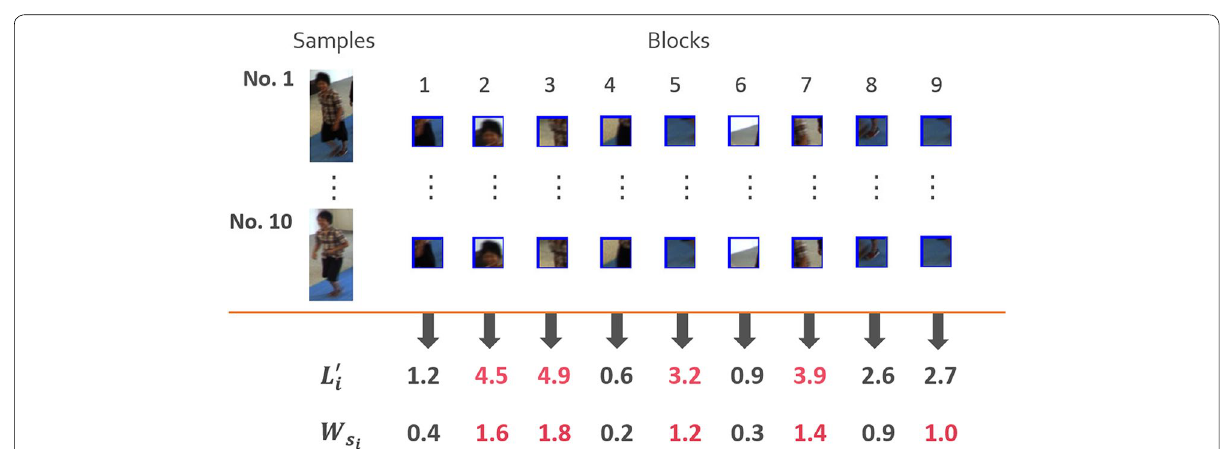
Fig. 8 Weight for each block. Images on the left are samples captured from tracking data. In this figure, detection windows are segmented into nine